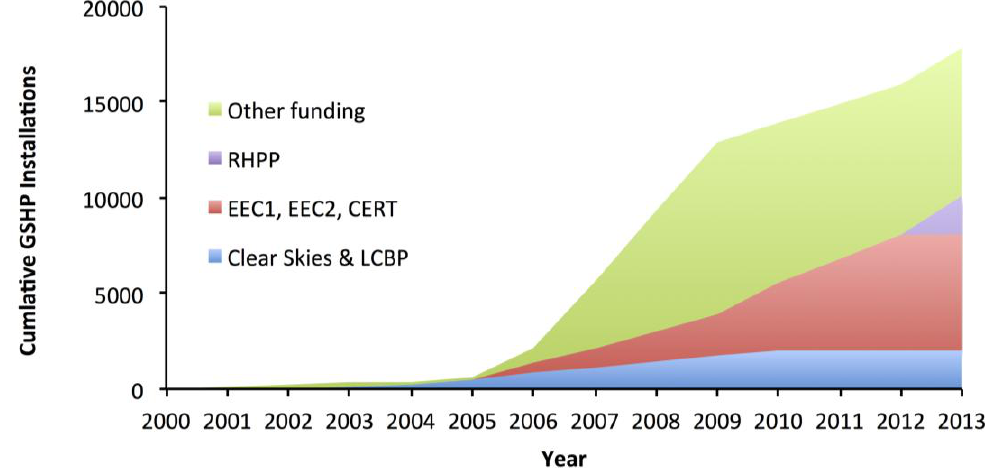
Figure 3. Growth of ground-source heat pump (GSHP) installations in the UK part